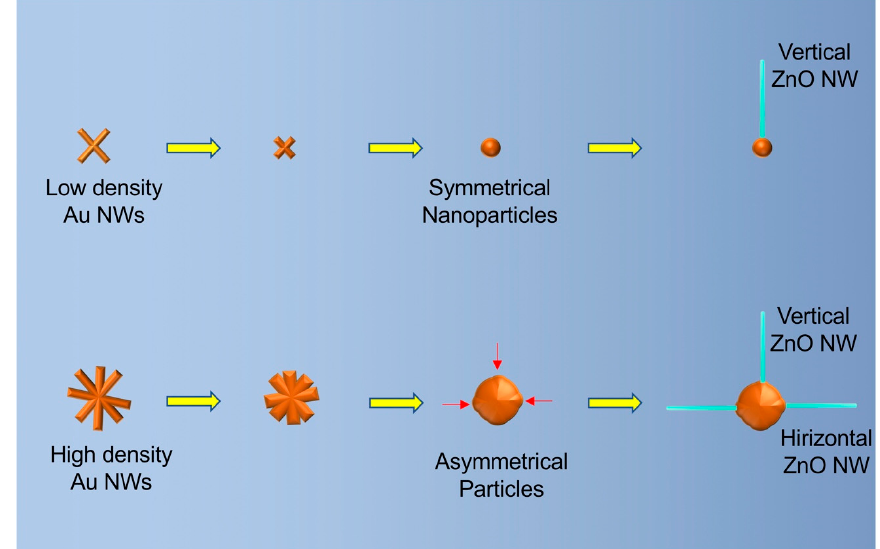
Figure 3. Schematic drawing of the mechanisms of the growing behaviors of ZnO nanowires on small (top) and large (bottom) gold particles. The red arrows indicate the high surface energy parts on the large gold particles.